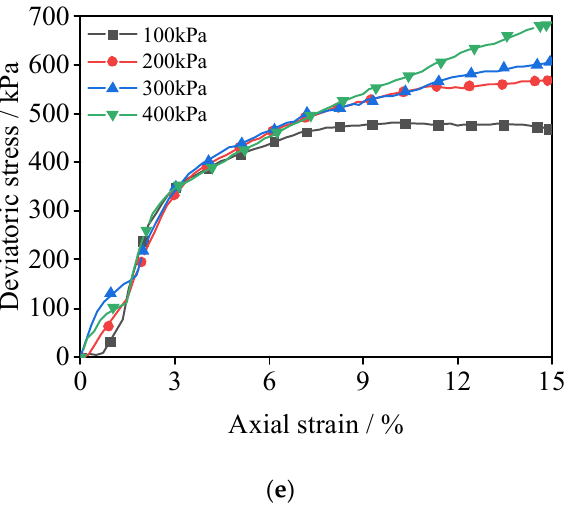
Figure 5. Deviatoric stress–strain curves of SCSC. ( a ) SCSC0 ( b ) SCSC4 ( c ) SCSC6 ( d ) SCSC8 ( e ) SCSC10.